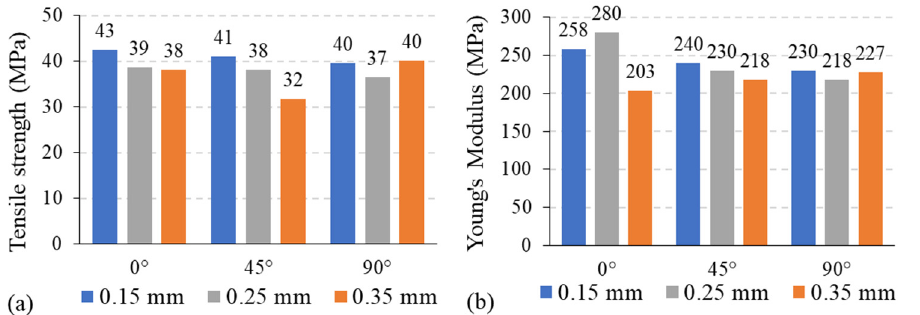
Figure 18. PETG ( a ) tensile strength and ( b ) Young’s modulus sensitivity to layer thickness with different raster angles (in degrees).